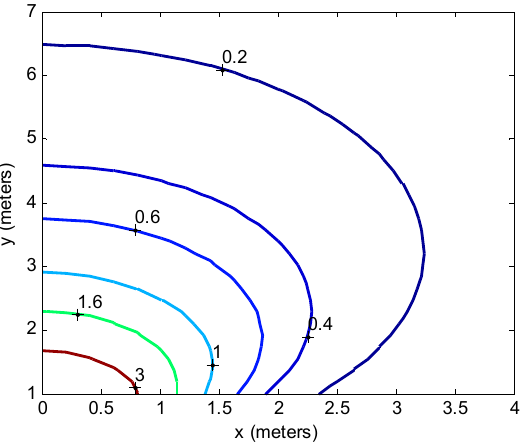
Figure 4. Plot of yy J for two dimensional location estimation (units of label numbers are m − 2 ). Figure 4. Plot of J yy for two dimensional location estimation (units of label numbers are m − 2